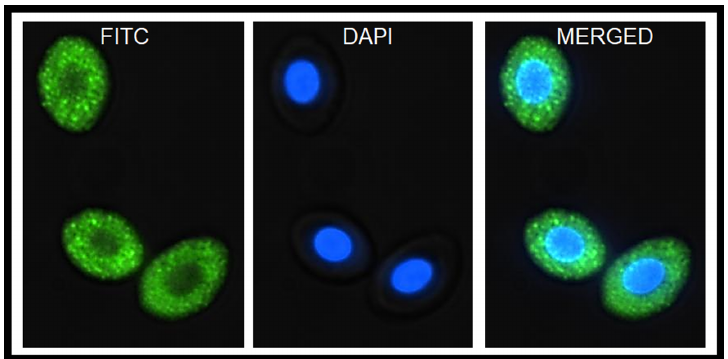
Fig 2. Constitutive expression of Mx antiviral protein in rainbow trout nucleated RBCs. Immunofluorescence images of Mx protein expression in nucleated RBCs. FITC: Mx protein expression; DAPI: nuclei. Images were obtained using an INCell Analyzer 6000 Cell imaging system (GE Healthcare, Little Chalfont, United Kingdom). DAPI, 4’,6-diamidino-2-phenylindole; FITC, Fluorescein-5-isothiocyanate; Mx, myxovirus resistance gene; RBC, red blood